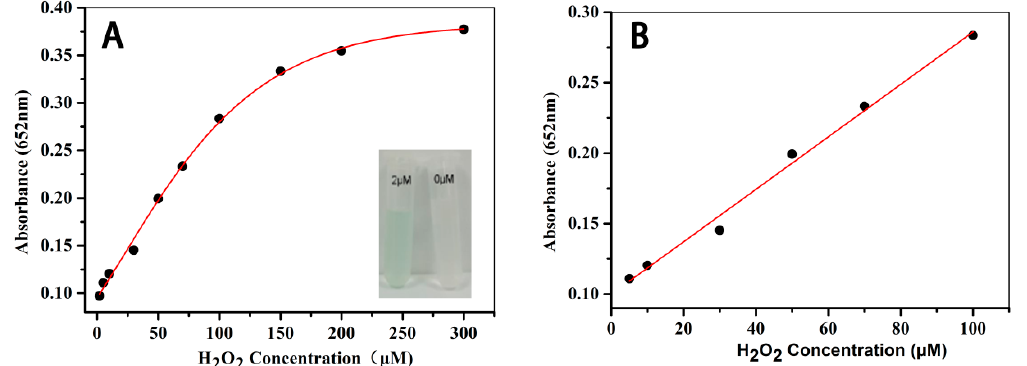
Figure 10. The dose-response curve for H 2 O 2 detection ( A ), the inset: the colored products of different concentration of H 2 O 2 (2 µ M and 0 µ M); the liner correlation between absorbance and H 2 O 2 concentration ( B ).